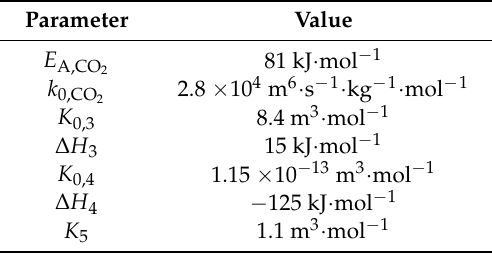
Table 3. Parameters of the kinetics of CO 2 methanation (see Equations (6) and (7)).